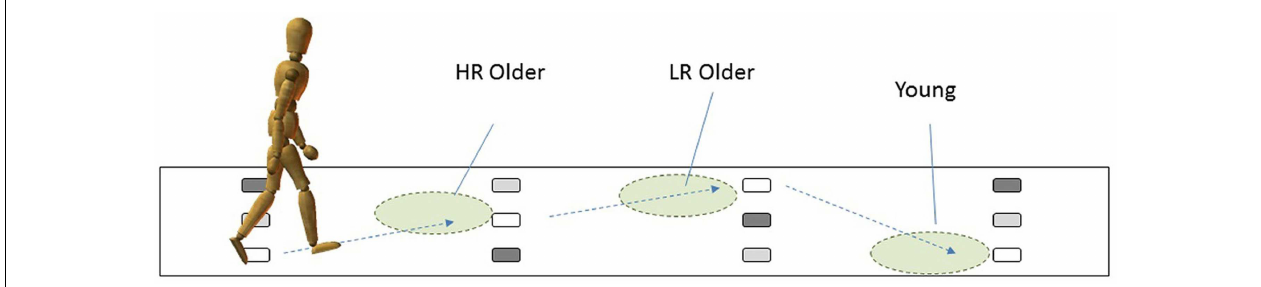
was stronger for those who were categorized as high risk (HR) older participants than for those who were categorized as low risk (LR) older participants.This figure was produced on the basis of the report inYamada et al. (2012), and reproduced with permission from Higuchi et al.